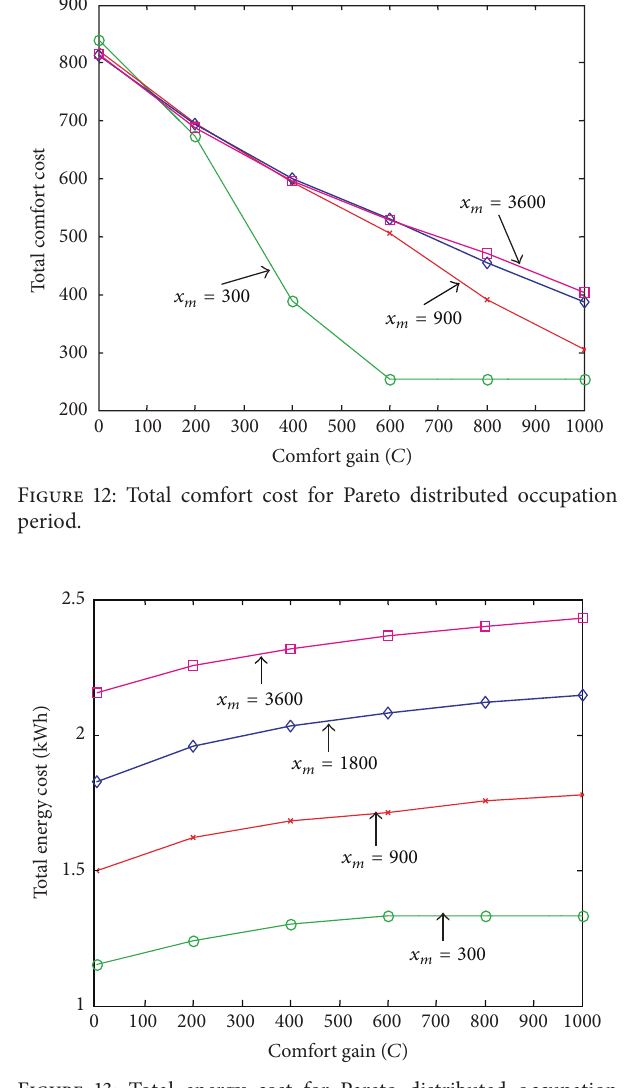
Figure 13: Total energy cost for Pareto distributed occupation period.